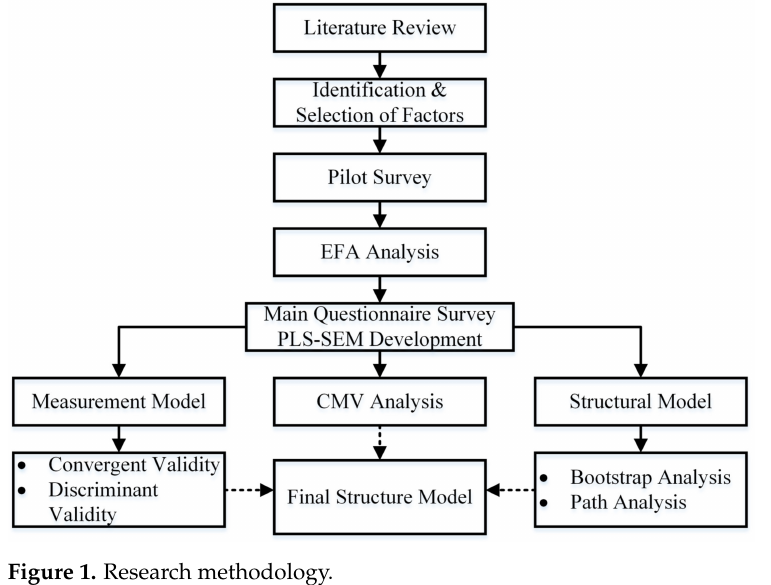
Figure 1. Research methodology.